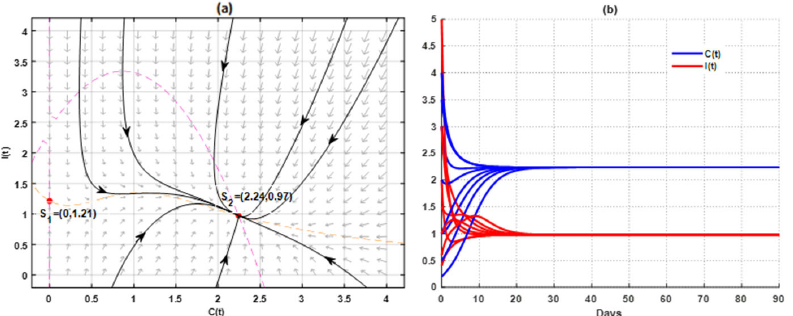
Figure 2. Numerical simulations of the CICV model for the data given in Table 1 with 𝛽 (cid:2869) (cid:3404) 𝛾 (cid:3404) 0 . ( a ) Phase portrait of the CICV model. ( b ) Time series of the CICV model. ( a ) Phase portrait of the CICV model. ( b ) Time series of the CICV